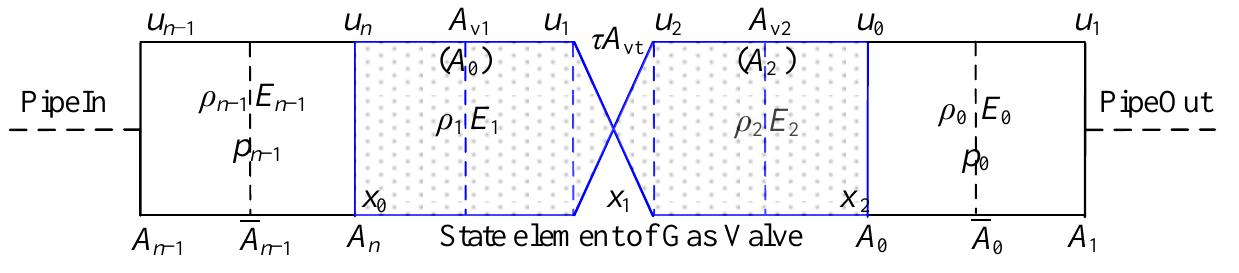
Figure 2. Finite control volume grids of gas valve.